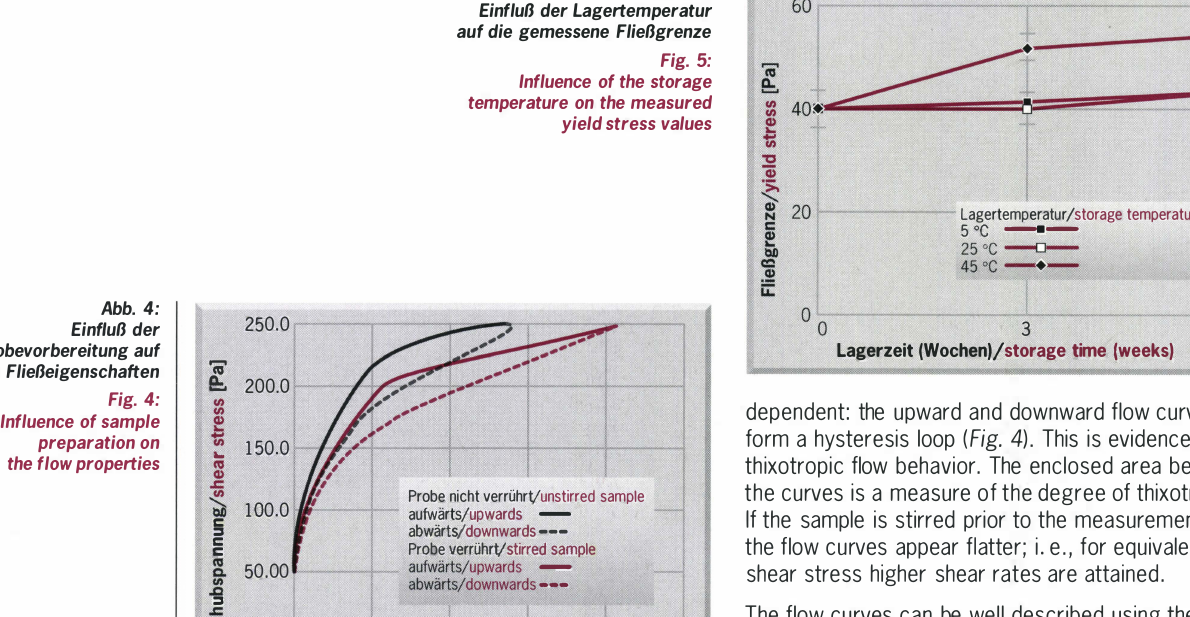
temperature on the measured yield stress